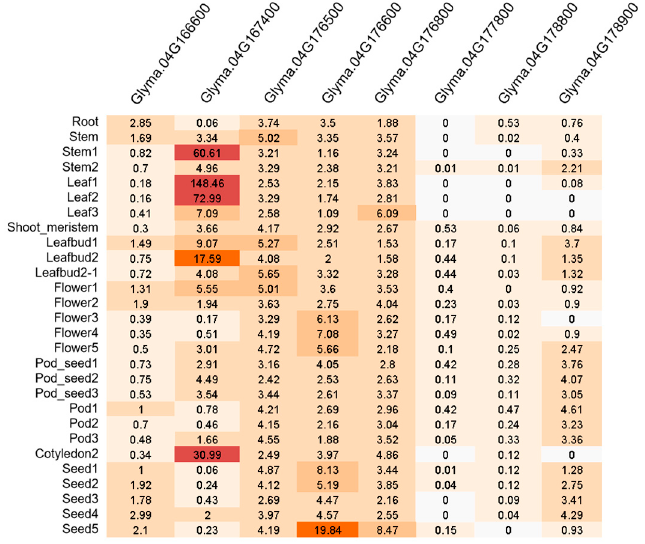
Figure 6. The expression patterns and relative levels of the eight genes in different tissues.